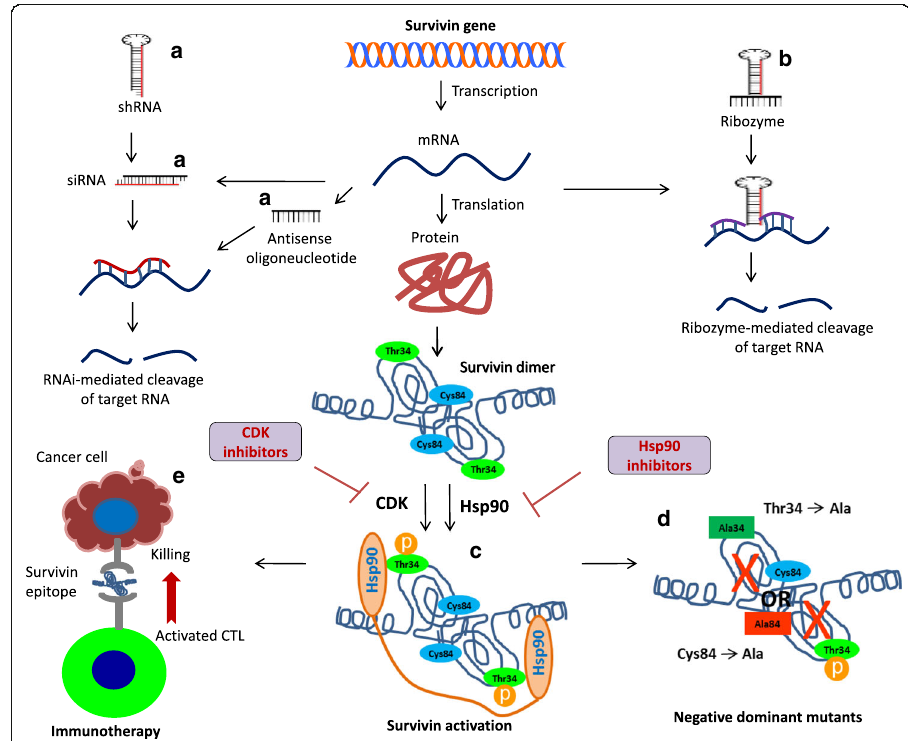
Fig. 3 Schematic representation of different techniques to target survivin for therapeutic purposes. a Antisense technology, such as antisense oligonucleotides, siRNA and shRNA target survivin mRNA to inhibit translation. b Ribozyme is also an advanced antisense method to target mRNA. The specificity of ribozyme determined by the paired regions flanking the cleavage site. c Dimerization and phosphorylation on Thr34 residue is essential for survivin activation and Hsp90 provide stability to survivin dimer. Small molecule antagonists for survivin activation, such as CDK and Hsp90 inhibitors, able to inhibit survivin phosphorylation or its interaction with Hsp90, consequently inhibit survivin functions. d In dominant negative mutants, an essential amino acid of the survivin is replaced by another amino acid that leads to the loss of function. For example, Thr34Ala mutant inhibit survivin activation through abolishing phosphorylation of Thr34 residue, and Cys84Ala mutant inhibit survivin dimerization. e Survivin-directed immunotherapy approaches. Peptides-derived from survivin can induce CTL activity against tumor